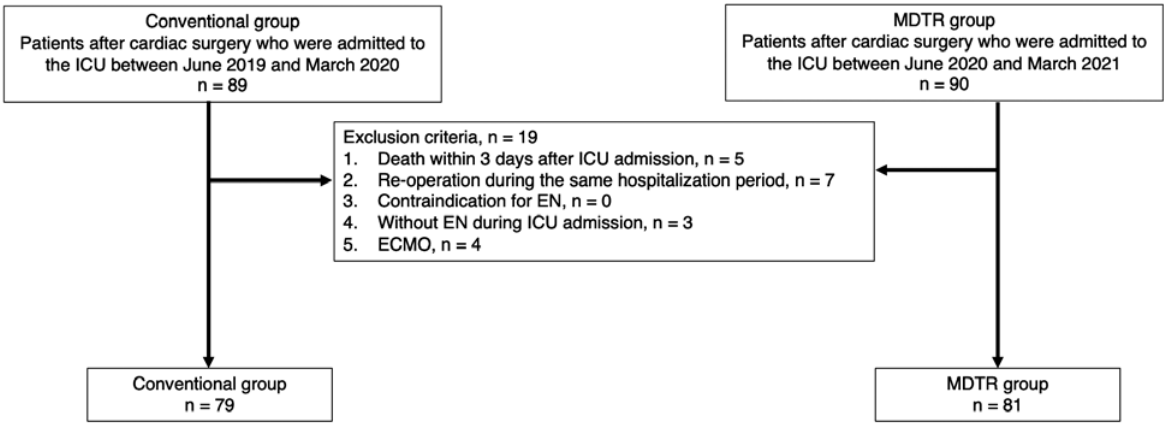
Figure 1. Flowchart of the study participant selection process. EN, enteral nutrition; ECMO, extracorporeal membrane oxygenation; ICU, intensive care unit; MDTR, multidisciplinary team rounds.